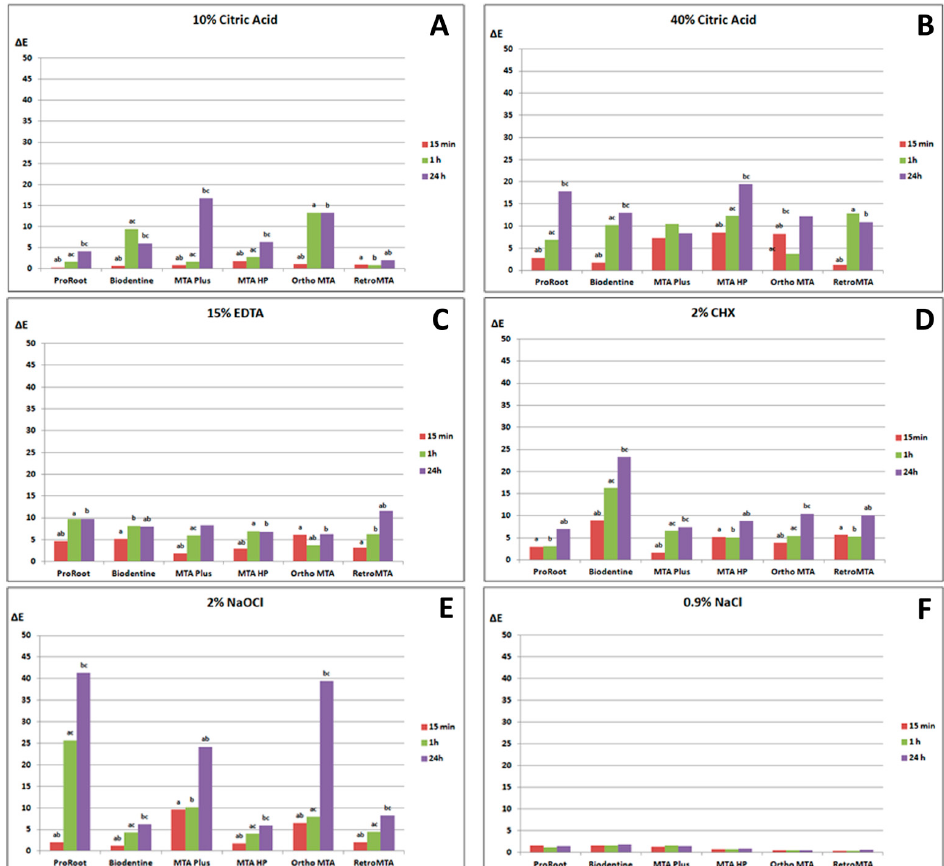
Figure 3. Mean Δ E values of CSCs materials after contact with irrigation solutions for different durations. ( a ) 10% CA; ( b ) 40% CA; ( c ) 15% EDTA; ( d ) 2% NaOCl; ( e ) 2% CHX; ( f ) 0.9% NaCl. (The same letters indicate statistically significant differences between different time points within the material group (P < 0.05).)